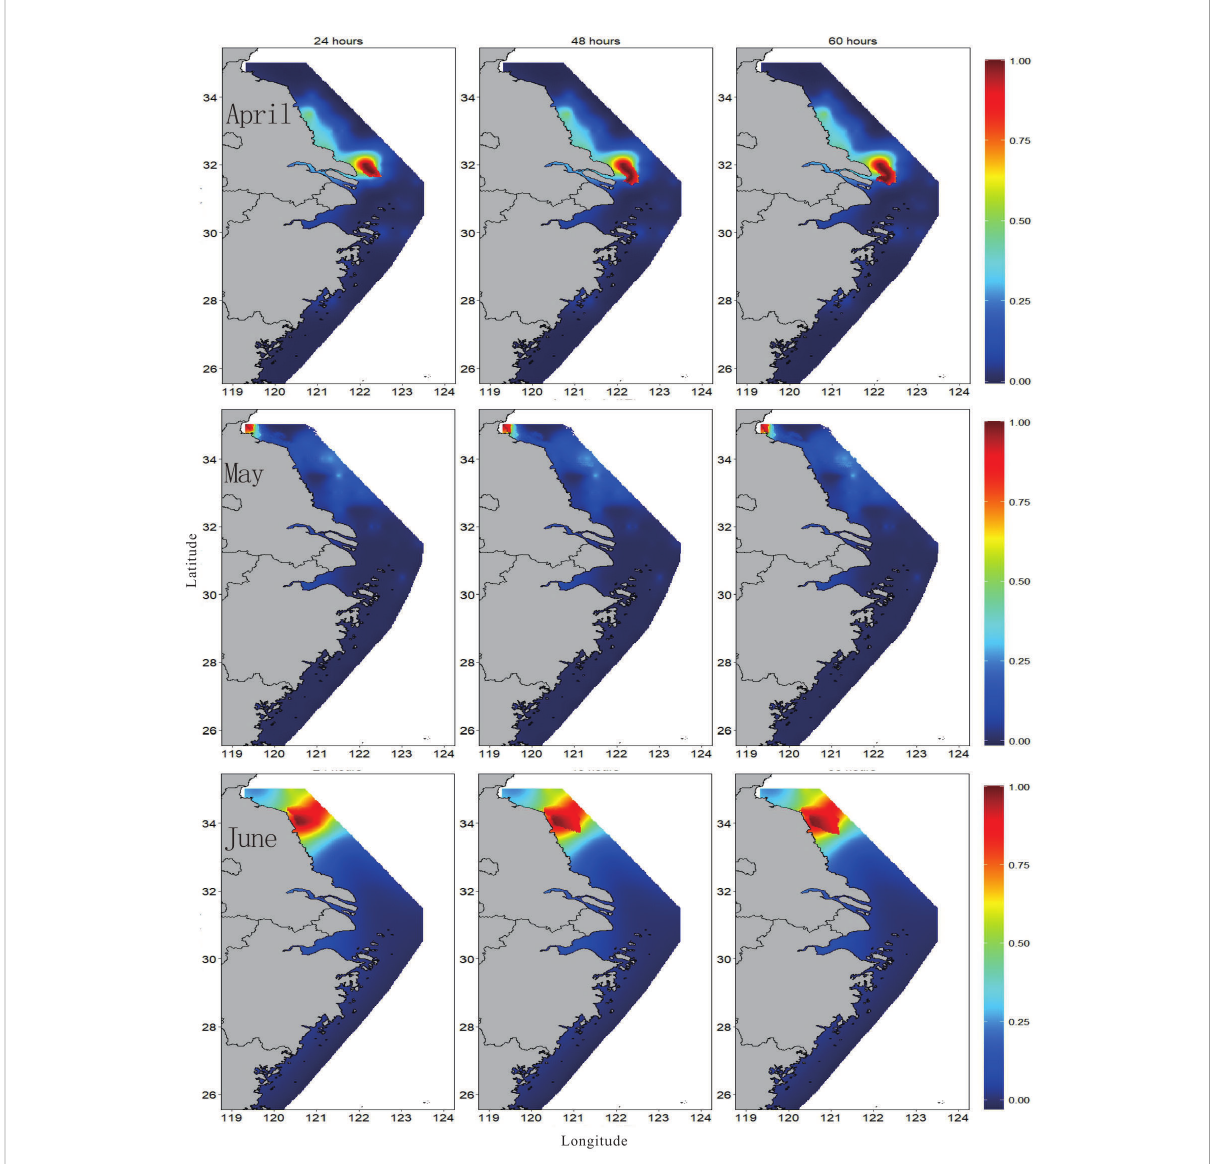
FIGURE 8 Spatial distribution of the priority protection index (BPPI) for the spawning grounds of small yellow croaker with 24 h, 48 h, and 60 h backward tracking of egg